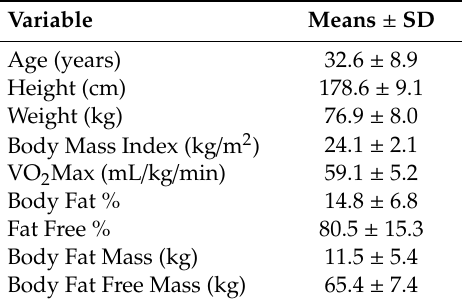
Table 1. Subject characteristics ( n = 13).